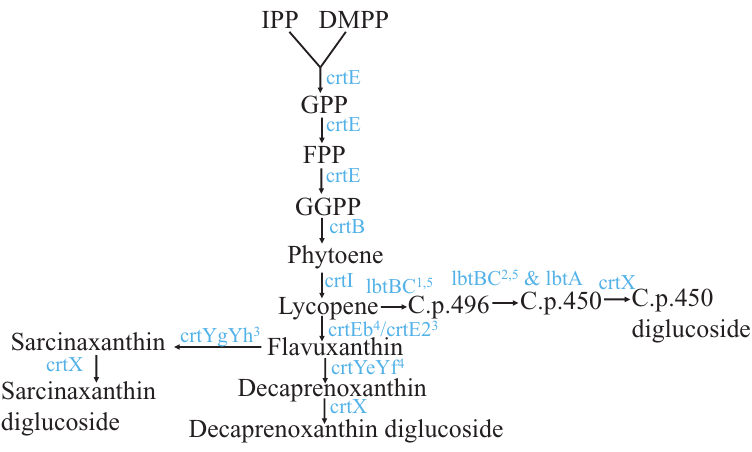
Figure 11. A schematic representation of the C 50 biosynthesis pathways in bacteria. C 40 carotenoid lycopene is diprenylated to form an acyclic C 50 carotenoid, flavuxanthin. Flavuxanthin undergoes cyclization in three different ways to form three types of natural C 50 carotenoids in bacteria. Substrates and intermediate products names are abbreviatedandareshowninblack.Genesencodingenzymescatalyzingspecificreactions/stepsinthepathwaysare shown in blue. Abbreviations: IPP, isopentenyl pyrophosphate; DMPP, dimethylallyl pyrophosphate; GPP, geranyl pyrophosphate;FPP,farensylpyrophosphate;GGPP,geranylgeranylpyrophosphate;C.p.496,2,2 0 -Bis-(3-methylbut- 2-enyl)-3,4,3 0 ,4 0 -tetradehydro-1,2,1 0 ,2 0 -tetrahydro- ψ , ψ -carotene-1,1-diol;C.p.450,2,2 0 -Bis-(4-hydroxy-3-